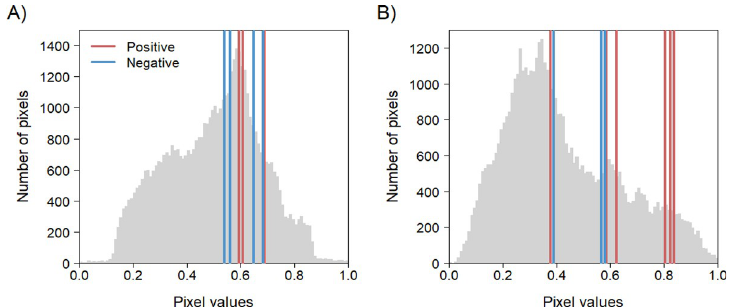
Fig 8. Pixel values distribution in suitability maps for Ebolavirus circulation in fruit bats (A) and insectivorous bats (B). Lines show pixel values of sampling sites where at least one bat tested positive for Ebolavirus antibodies (red lines) or where all bats tested negative (blue lines).